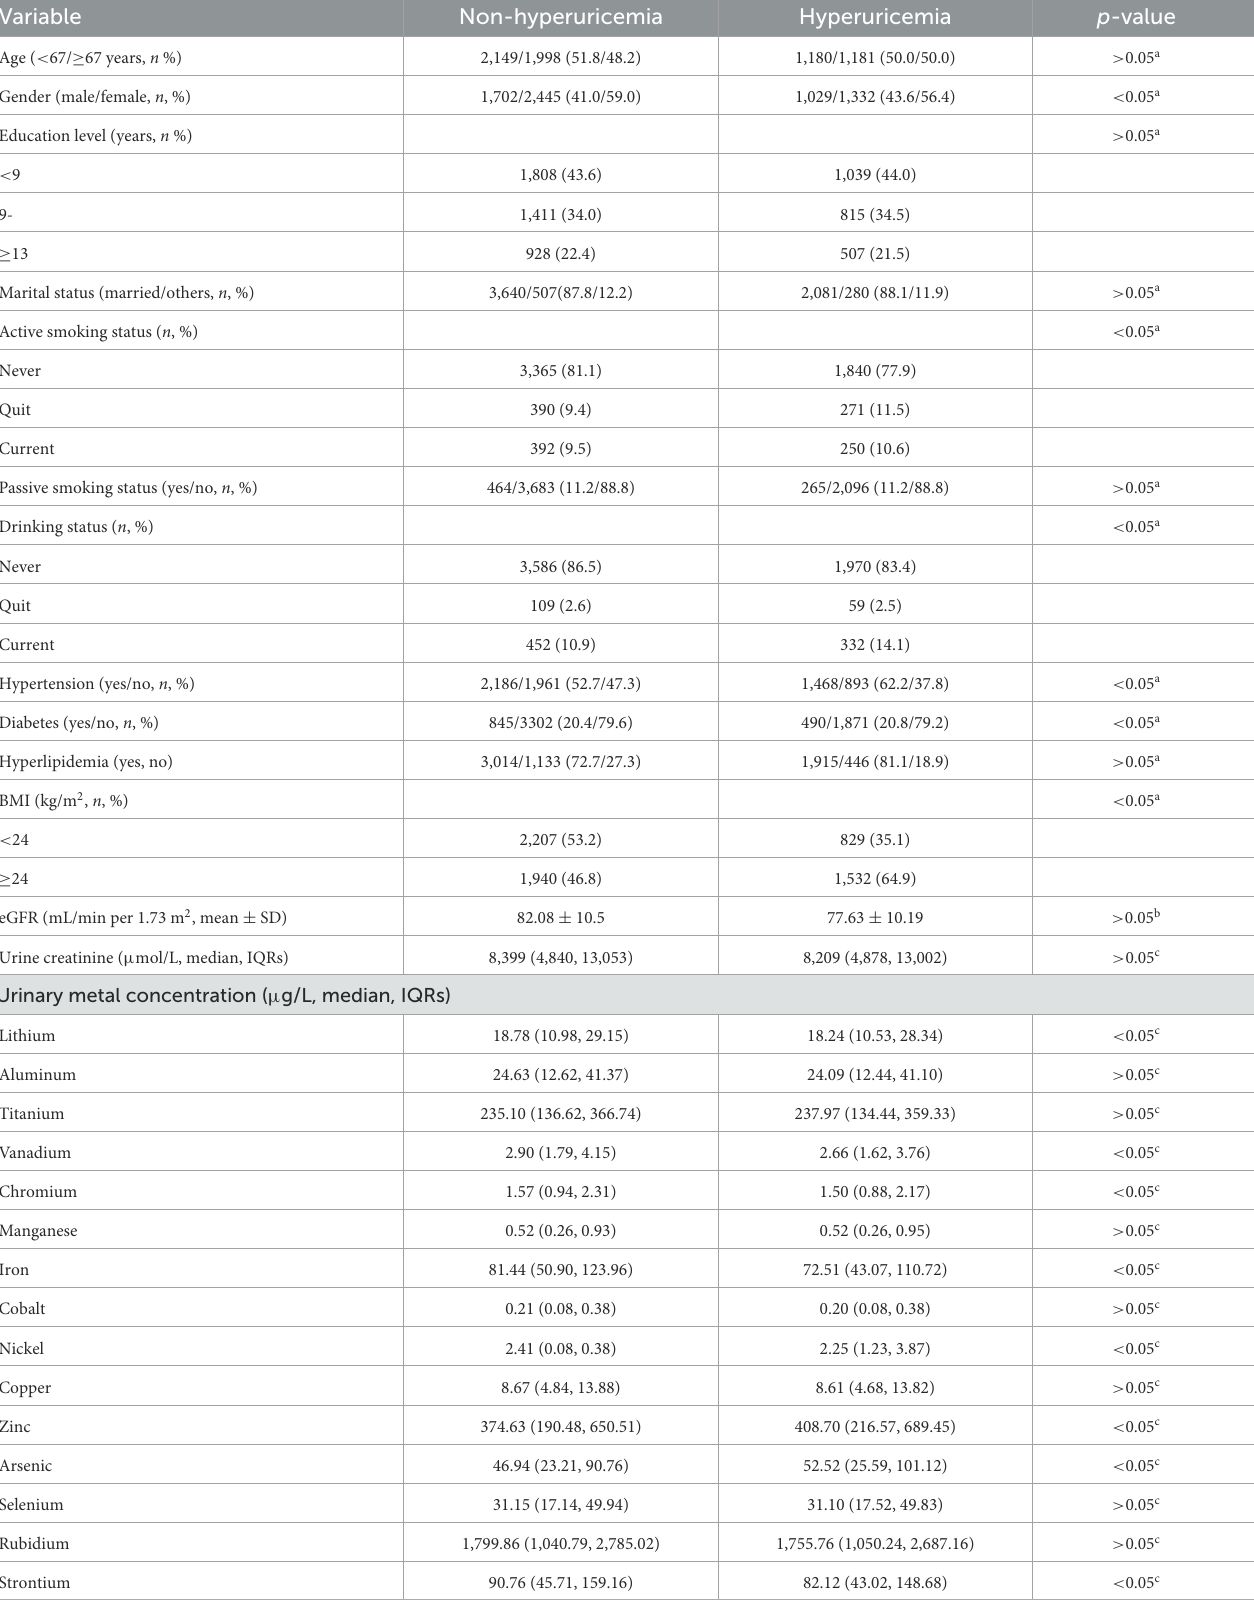
TABLE 1 Characteristics and urinary metal concentrations of the study population.